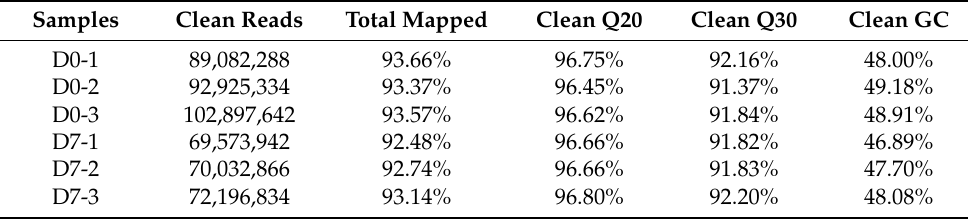
Figure 1. Ovine skeletal muscle satellite cell isolation and gene expression levels. ( A ) Immunofluorescent staining results at the proliferation and differentiation stages; ( B ) principal component analysis of six samples; ( C ) the expression level of mRNAs; FPKM represents the fragments per kilobase of transcript per million mapped reads. Table 2. Summary of the RNA-Seq data for each